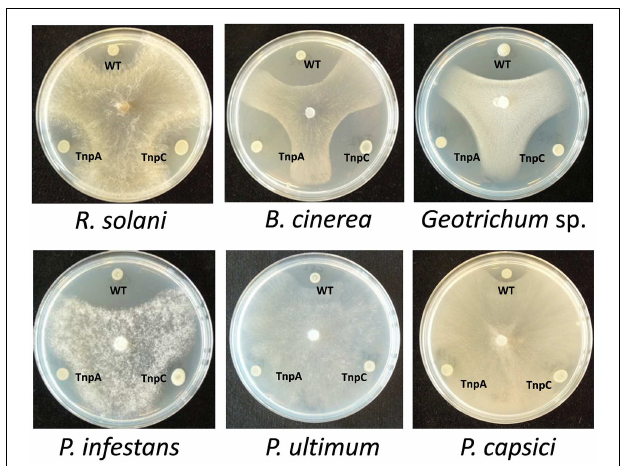
FIGURE 6 | Antagonistic activity of Pseudomonas sp. SH-C52. The wild-type (WT) and the thanapeptin mutants strains, Tn- tnpA (TnpA) and Tn- tnpC (TnpC) were tested in dual culture assays for activity against fungal plant pathogens (upper panel) and oomycete plant pathogens (lower panel) .